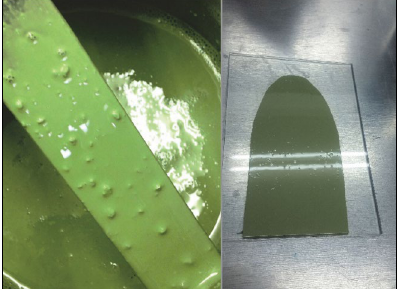
Figure 4. Incompatibility in sample